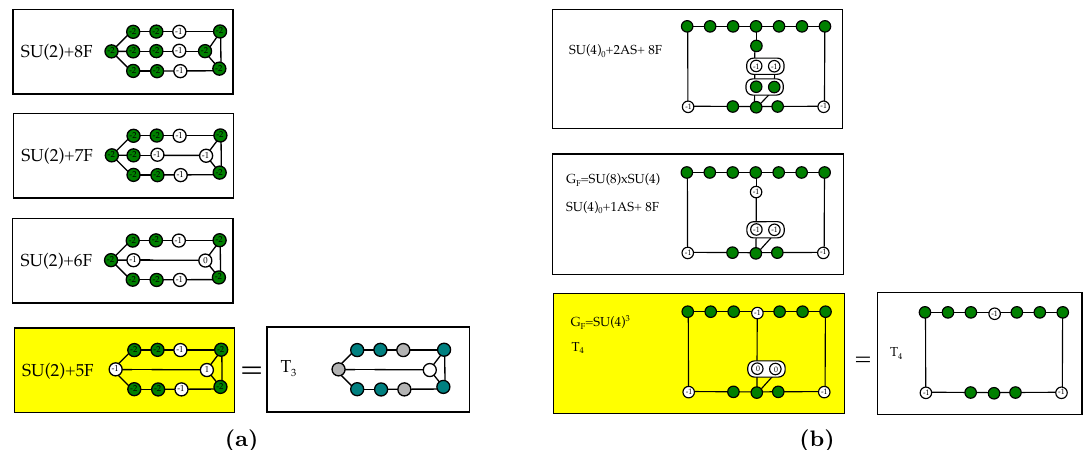
Figure 16 . (a) T 3 as a descendant of the ( E 6 ; SU(3)) Rank one conformal matter theory. (b) T 4